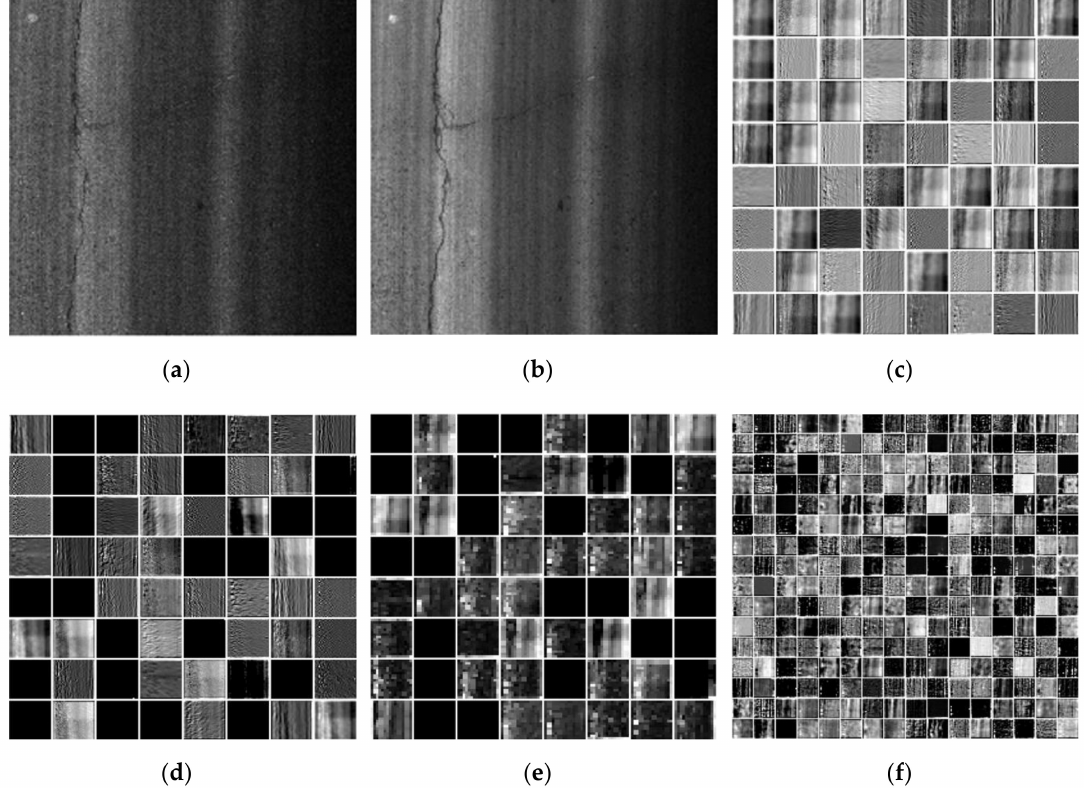
Figure 11. The original image and the images in each step of pre-processing. ( a ) Original image. ( b ) Preprocessed image. ( c ) Convolutional layer. ( d ) rectified linear unit (ReLU) 1-1. ( e ) Max pooling layer 1-1. ( f ) Fully connected layer